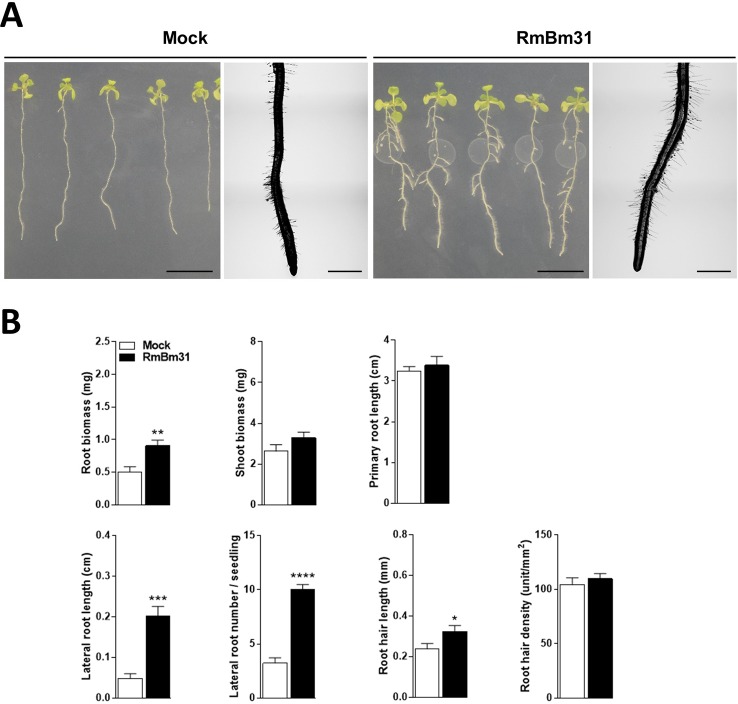
Phenotypic effects of Bacillus megaterium RmBm31 on Arabidopsis thaliana Col-0 seedlings 7 days post inoculation (dpi). Five-day-old seedlings were either mock-treated (“Mock”) or inoculated with 10 µl of RmBm31 at 2.106 CFU.ml−1 in MgS04 10 mM (“RmBm31”). (A) Pictures of whole seedlings (scale bar, 1 cm) and macroscopy pictures of root tips (scale bar, 1 mm) at 7 dpi. (B) Root and shoot biomass of the seedlings and quantitative phenotypic analysis of their root system architecture at 7 dpi. Data are means ± SEM of nine biological replicates (n) from three independent experiments. Stars indicate statistically significant differences between the mock- and RmBm31-treated conditions according to a Mann–Whitney–Wilcoxon test (ns, nonsignificant ; *, P < 0,05; **, P < 0,01; ***, P < 0,001; ****, P < 0,0001).